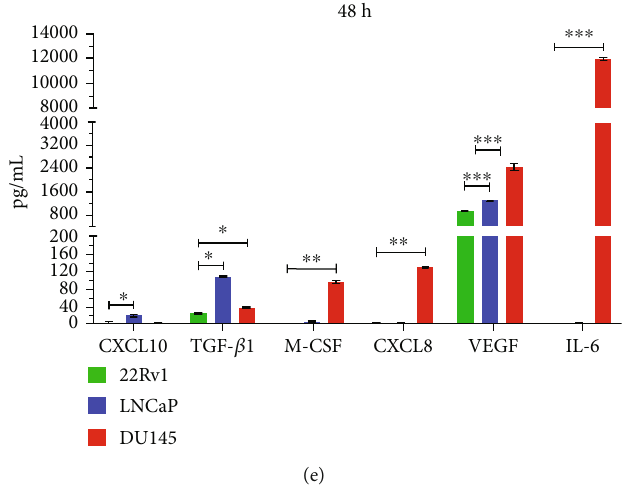
Figure 1: Advanced prostate cancer cells secrete a higher concentration of growth factors and cytokines according to stage progression. The cells were cultured at di ff erent times, the supernatants from PCa lines were collected, and 13 cytokines and 10 growth factors were evaluated using LEGENDplex ™ technology. (a, b) The concentration of growth factors and cytokines from the 22Rv1, LNCaP, and DU145 supernatant was evaluated at 12, 24, and 48h. (c,e) The concentration of soluble molecules increases, conforming with the advances of stage progression; the highest VEGF, M-CSF, CXCL8, and IL-6 values were observed in the DU145 cell line. Data are shown as the mean ± SD . ∗ p < 0 : 05 , ∗∗ p < 0 : 01 , ∗∗∗ p < 0 : 001 (ANOVA with Tukey ’ s multiple comparison